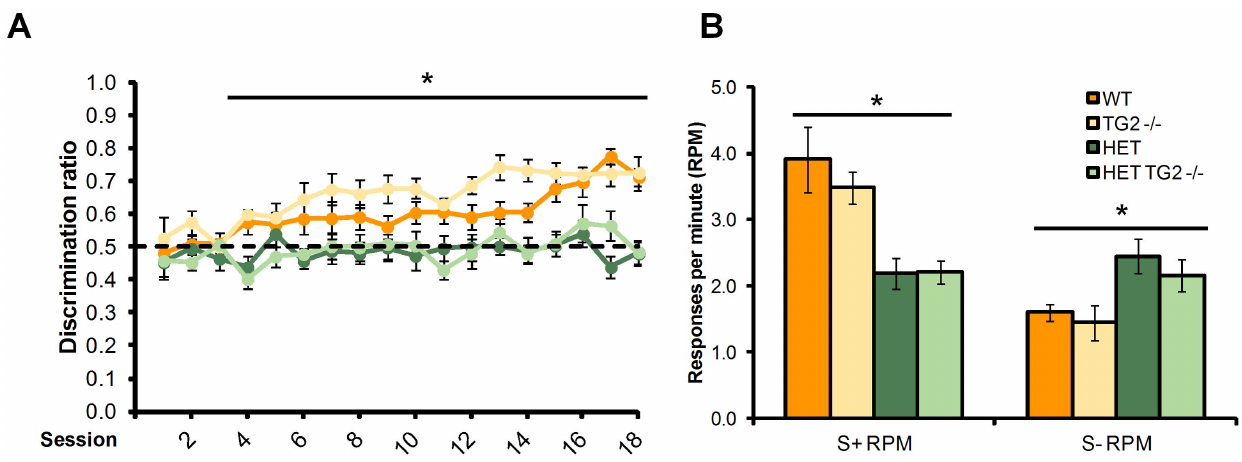
Figure 10. Discrimination performance (n=6–12 per genotype). A. Discrimination ratio across the training period. B. Response rate for the reinforced (S + RPM) and unreinforced (S- RPM) conditions averaged across the final four sessions for the zQ175 6 TG2 KO line. *Significant HD